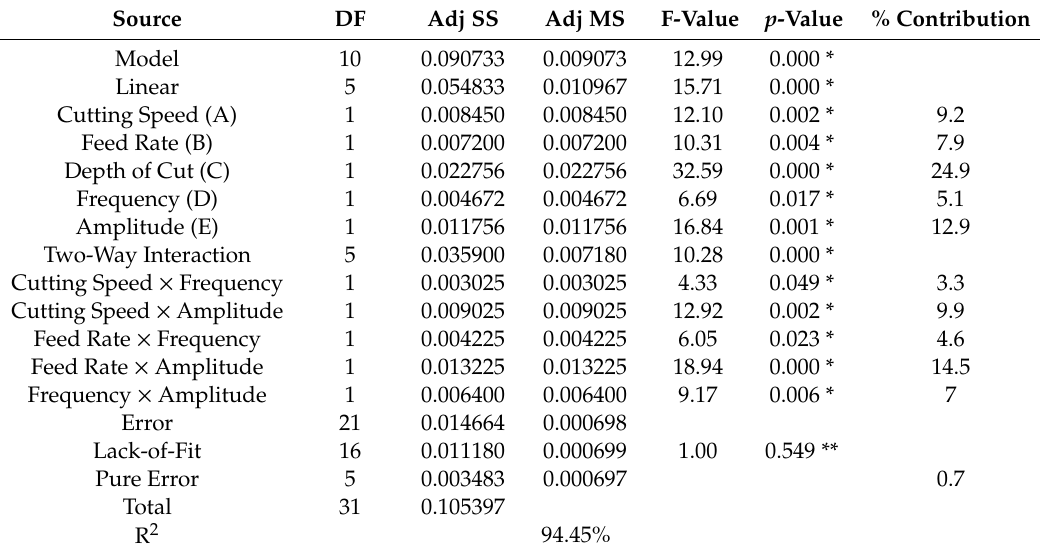
Figure 4. 2D surface profiles of the fabricated pockets ( a ), Exp. #1 ( b ) Exp. #14, ( c ) Exp. #21. Table 4. ANOVA results of